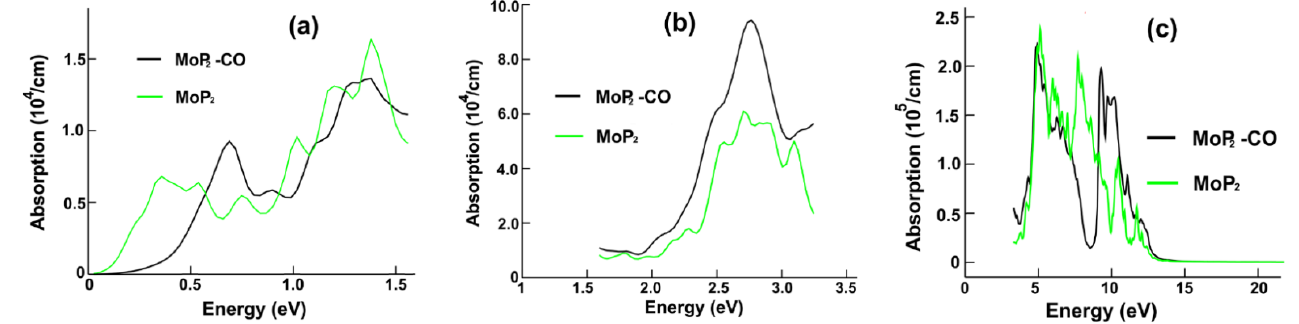
Figure 6. Optical absorption for pristine MoP 2 and MoP 2 -CO; ( a ) in the infrared range; ( b ) for the visible region; ( c ) for the ultraviolet range.